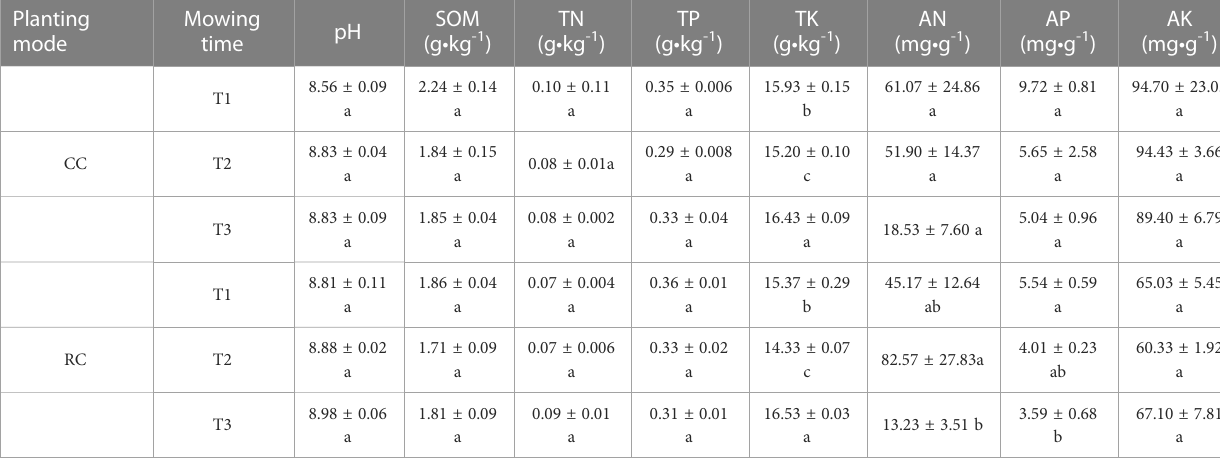
(Table 3), the other parameters of soil salinity did not respond signi fi cantly to planting pattern and mowing time (Table 4).